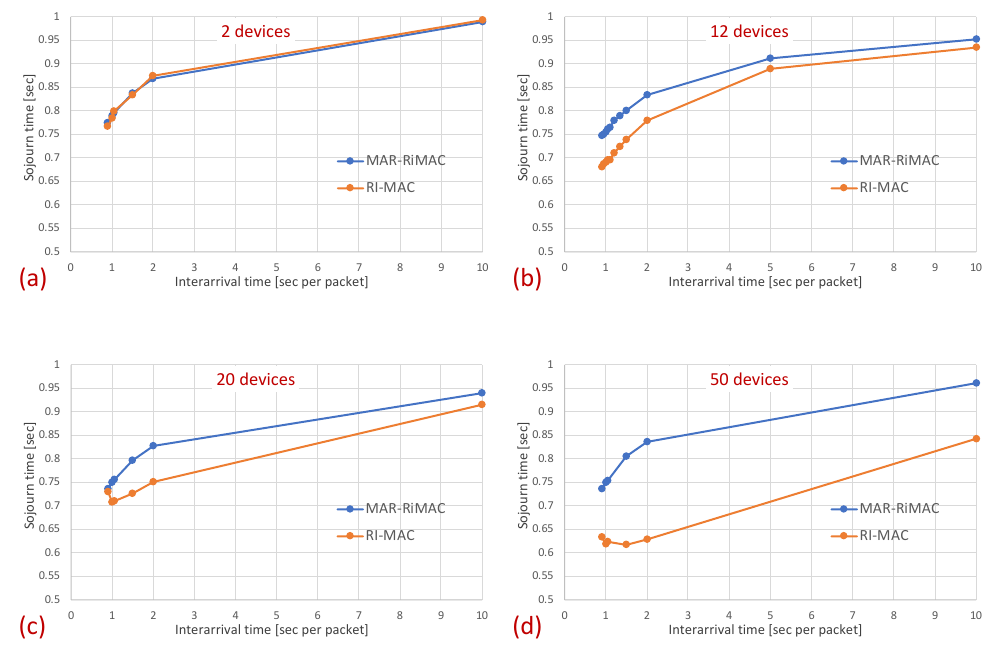
Figure 10. Hidden terminals: Mean sojourn time for different numbers of devices and K = 4. ( a ) Two devices. ( b ) Twelve devices. ( c ) Twenty devices. ( d ) Fifty